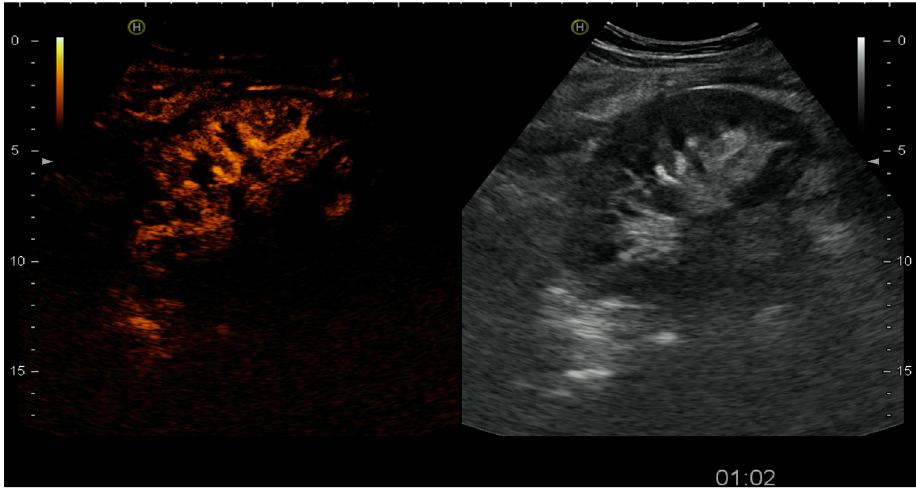
Figure 5. Cortical necrosis with an anechoic cortical halo.